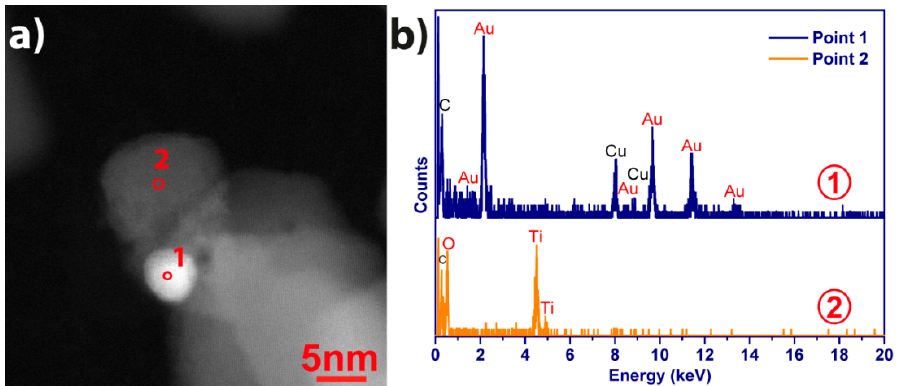
Figure 3. The STEM-HAADF- energy-dispersive X-ray spectroscopy (EDX) image of Au / TiO 2 nanocomposites with the identification of the measured points: Au (1) and TiO 2 (2) ( a ), EDX spectra with elemental identification (Au, Ti, O, and C) for points 1 and 2 ( b ). The Au / TiO 2 nanocomposite synthesized at 60 °C and with an Au loading of 0.05 wt. % was used.